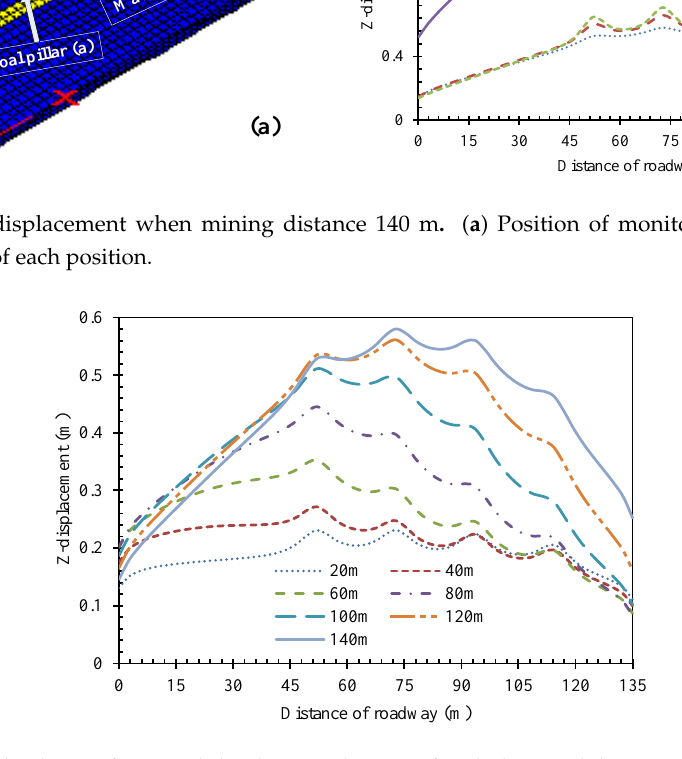
Figure 14. Subsidence of materials haulage roadway roof with the panel distances changeability.